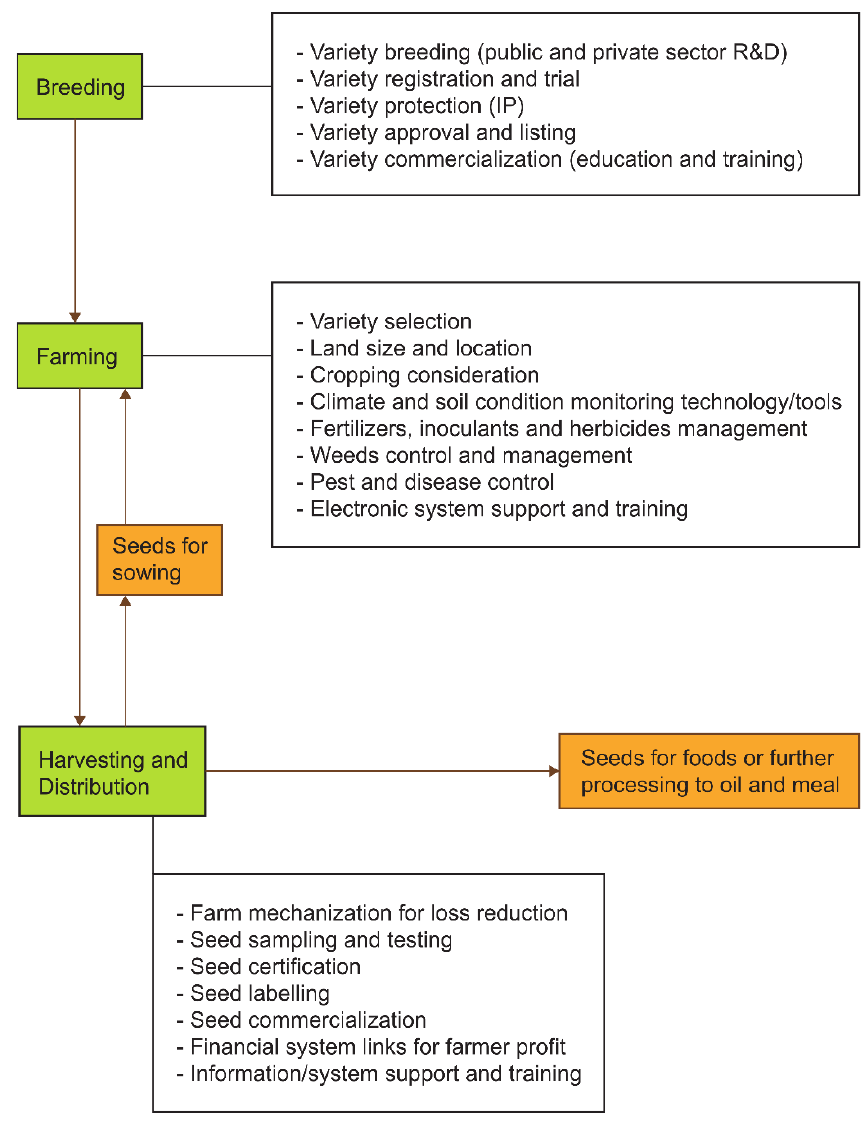
Figure 3. Soybean production supply chain.